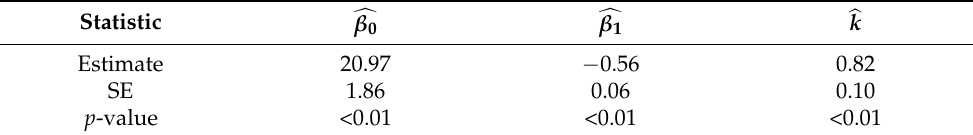
Table 11. Estimate, SE, and p -value of the indicated parameter for the data of time to electrical breakdown of an insulating